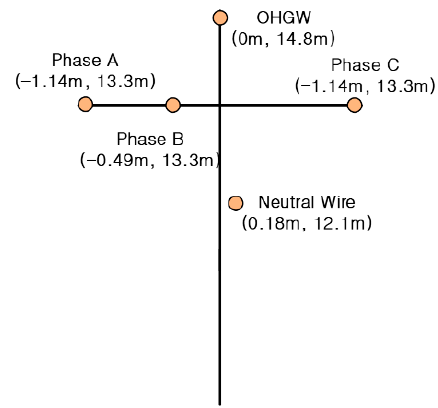
Figure 7. Configuration of modelled pole.